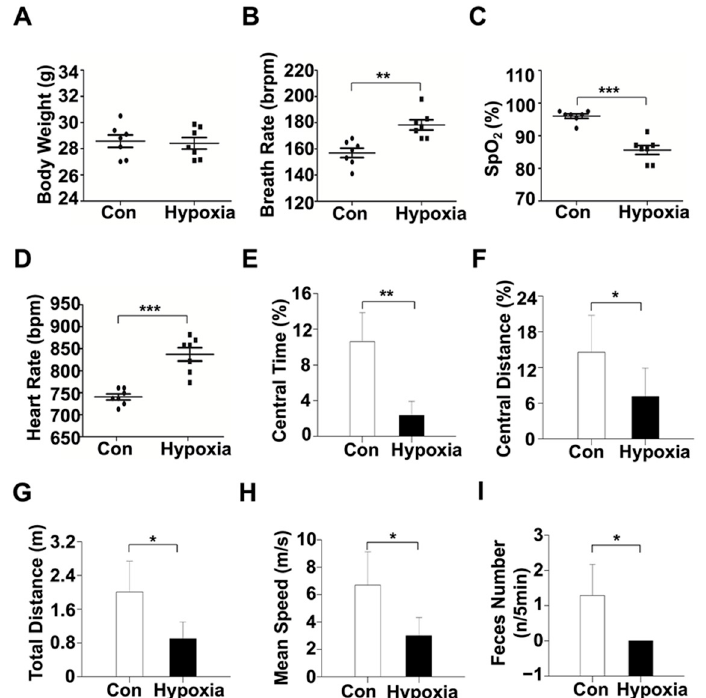
Figure 1. Changes of physiological values and behavior metrics in hypoxic mice. ( A – D ) Body weight, respiratory frequency, SpO 2 and heart rate in hypoxic mice and controls (both, n = 7). ( E – I ) Open field test in hypoxic mice and controls. *, p < 0.05, **, p < 0.01, ***, p < 0.001. The error bars represent SEM.